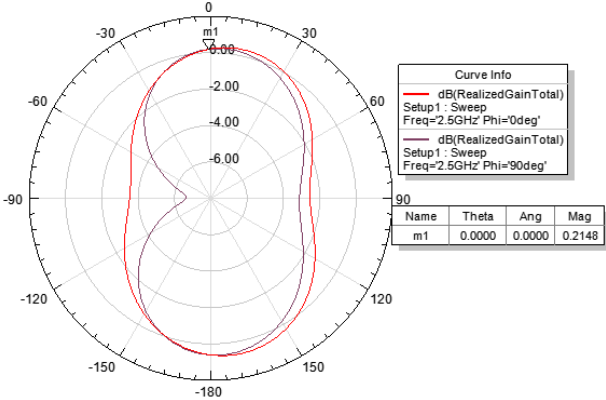
The realized gain was found to be 0.2148 dB at the resonating frequency of 2.5 GHz and is shown in Fig. 9.